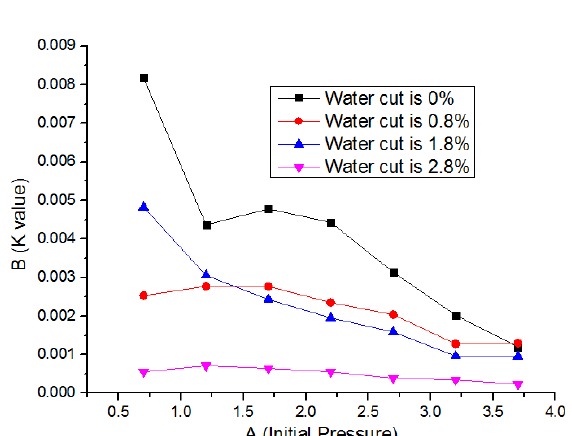
Figure 5 - The k values obtained for different levels of moisture